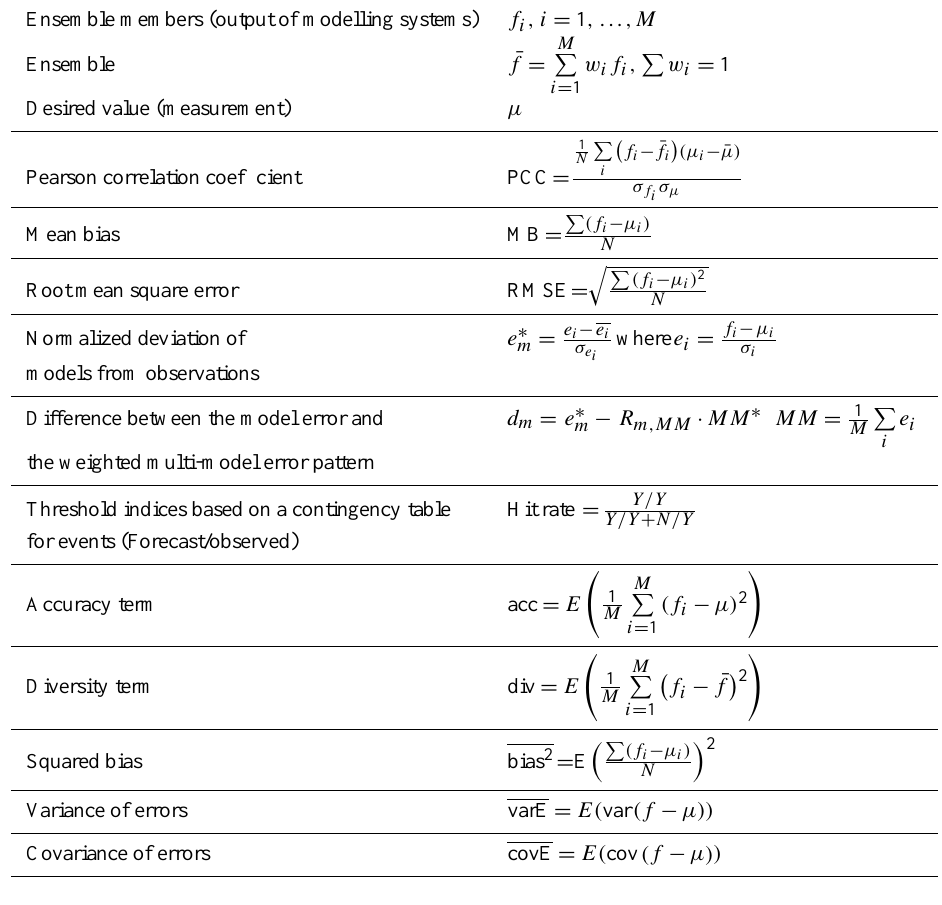
Table 1. Notation and indices of skill and redundancy. A ∗ indicates standardized vectors. Ensemble members (output of modelling systems) f i , i = 1 ,